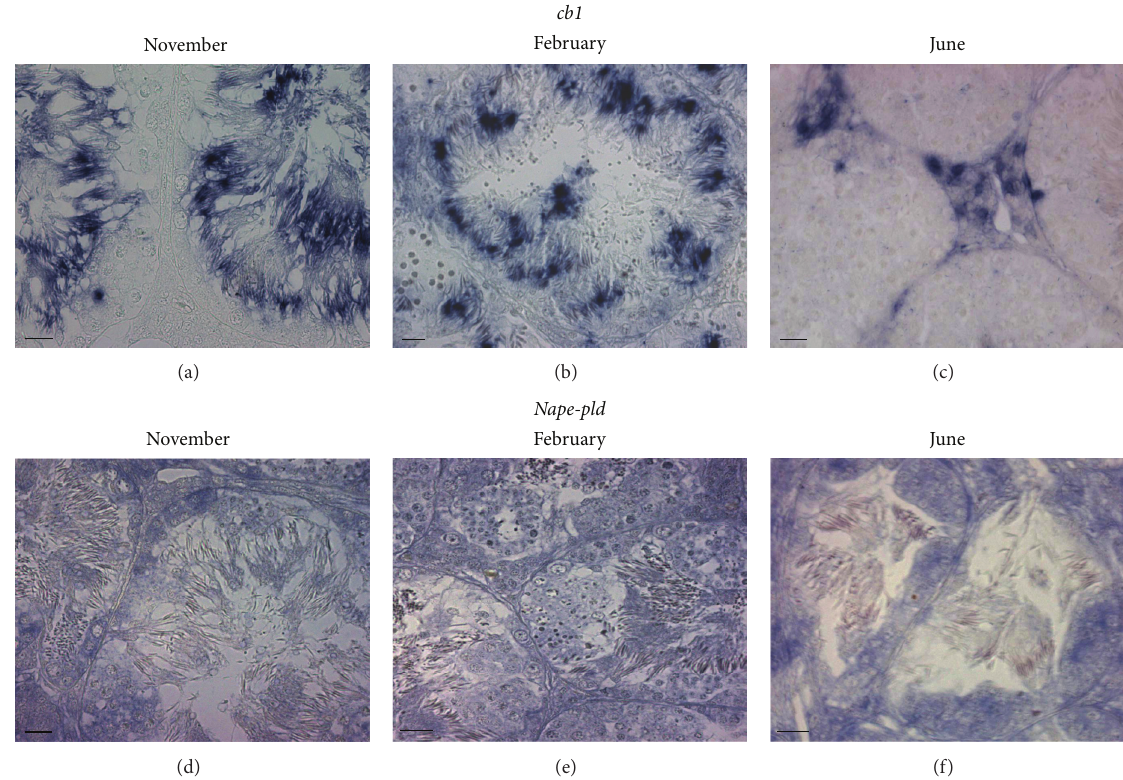
Figure 1: Localization of cb1 and Nape-pld mRNA in the frog testis evaluated by in situ hybridization in November (a) and (d), February (b) and (e), and June (c) and (f). Scale bar: 20 𝜇